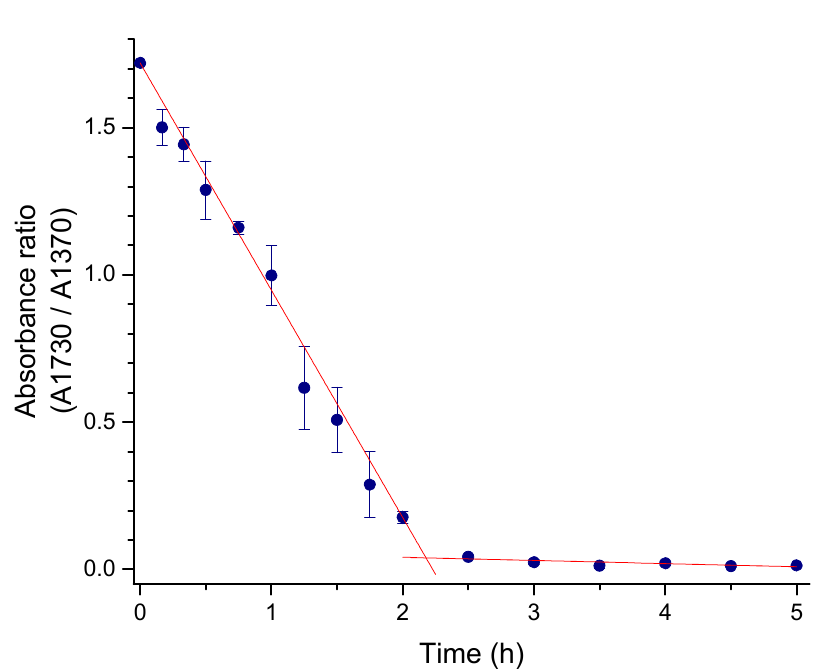
Figure 6. Selected bands absorbance ratio (A1740/A1370) of AC through the M1 treatment time.